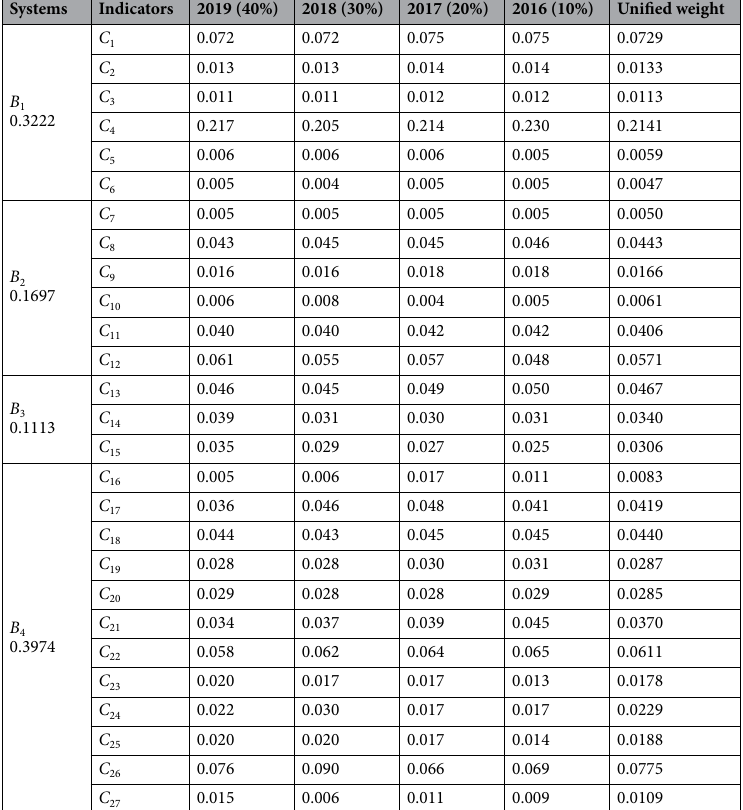
Table 6. Weight of indexes for resilience capacity